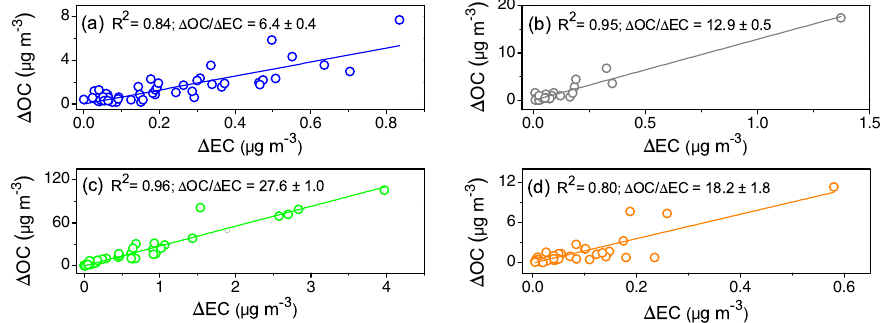
Figure 4. Seasonal relationship between EC and OC: winter (a) , spring (b) , summer (c) , and fall (d) during pollution periods, using all data obtained at ZOTTO from April 2010 to June 2014. The linear fit is shown for reference: R 2 – coefficient of determination; (cid:49) OC /(cid:49) EC slope ± 1SD. The polluted (cid:49) EC and (cid:49) OC concentrations were calculated as the difference between measured and REBS-defined background concentrations.